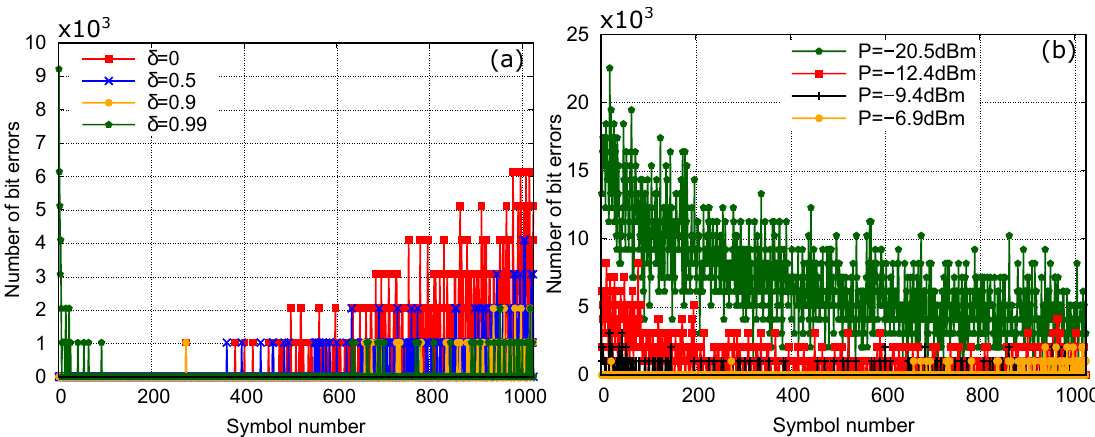
Figure 6. Number of bit errors versus symbol position after the transmission of 10 bursts of N b = 1024 symbols ( a ) at P = − 7 dBm for different tilt strengths, ( b ) at different power levels, for tilt strength δ =